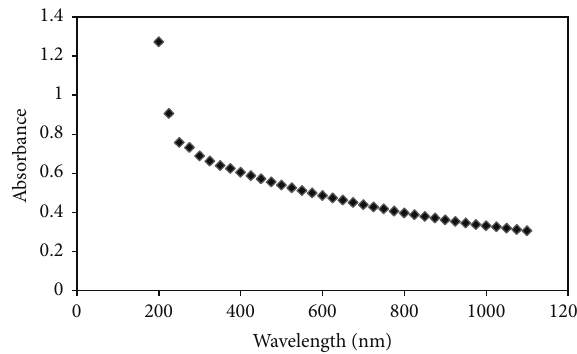
Figure 6: UV-Vis spectra for Al 2 O 3 ⋅ CaO nanocatalyst.